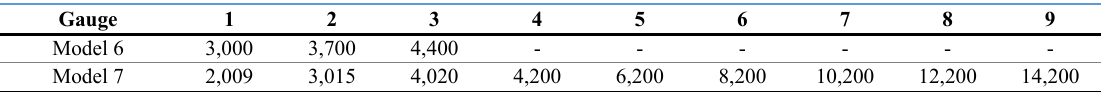
Table 11. Distance in meters from the external gauges to the explosion center.